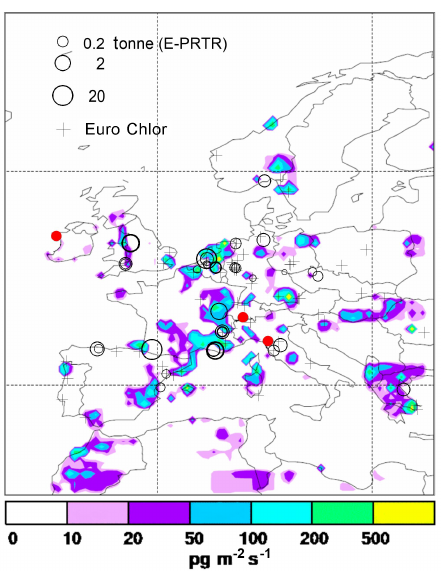
Figure 6. Average a posteriori distribution of CCl 4 emissions from the European geographical domain over the study period. Measure- ment stations are marked with red dots. Open circles represent emis- sions into the atmosphere as reported by the E-PRTR inventory. Crosses correspond to the location of chlor-alkali plants listed in Euro Chlor.